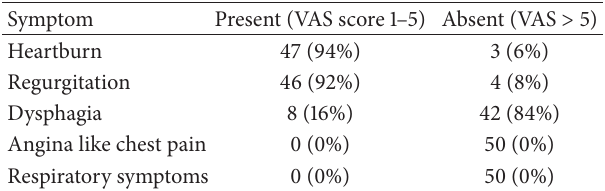
Table 1: Symptomatology at presentation.